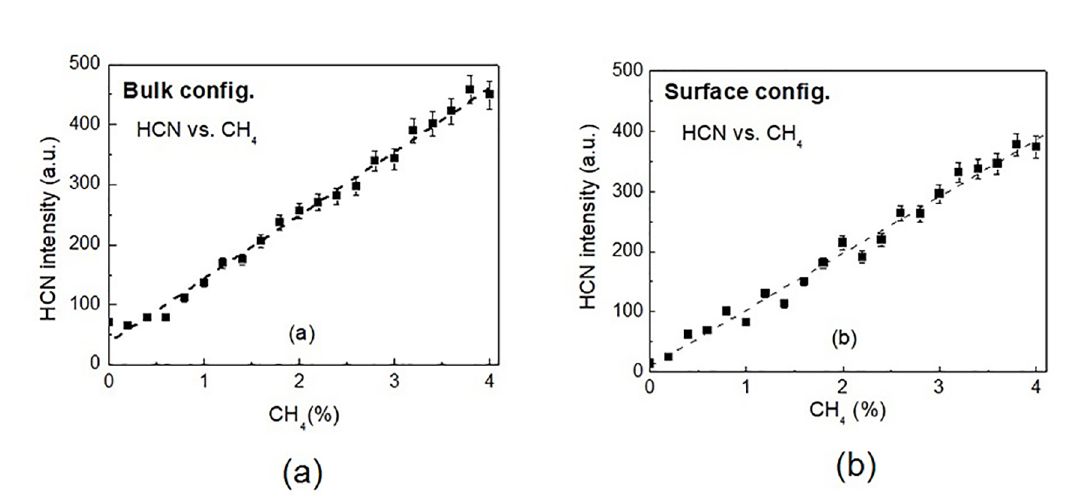
/H /CH mixture (a) Bulk 2 2 4